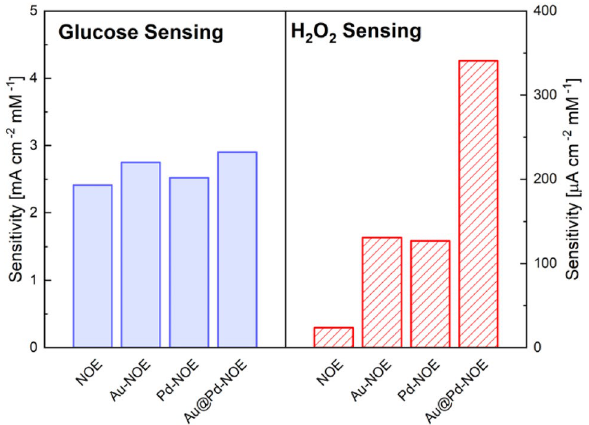
Figure 6. Sensitivity of NOE, Au-NOE, Pd-NOE, and Au@Pd-NOE for glucose and H 2 O 2